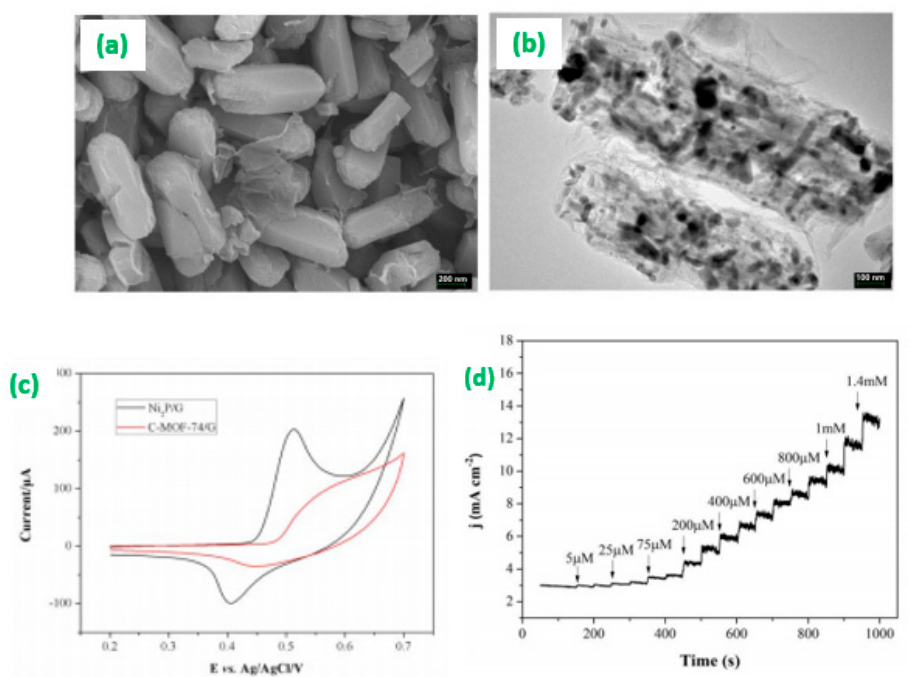
Figure 2. ( a ) SEM image and ( b ) TEM image of Ni 2 P / G, ( c ) CVs of Ni 2 P / G / GCE (black) and C-Ni-MOF-74 / G / GCE (red), and ( d ) amperometric responses of Ni 2 P / G / GCE to successive additions of glucose (in 0.1 M NaOH solution with the potential of 0.5 V vs. Ag / AgCl electrode). Reproduced from Zhang, Y.; Xu, J.; Xia, J.; Zhang, F. and Wang, Z., 2018. MOF-Derived Porous Ni 2 P / Graphene